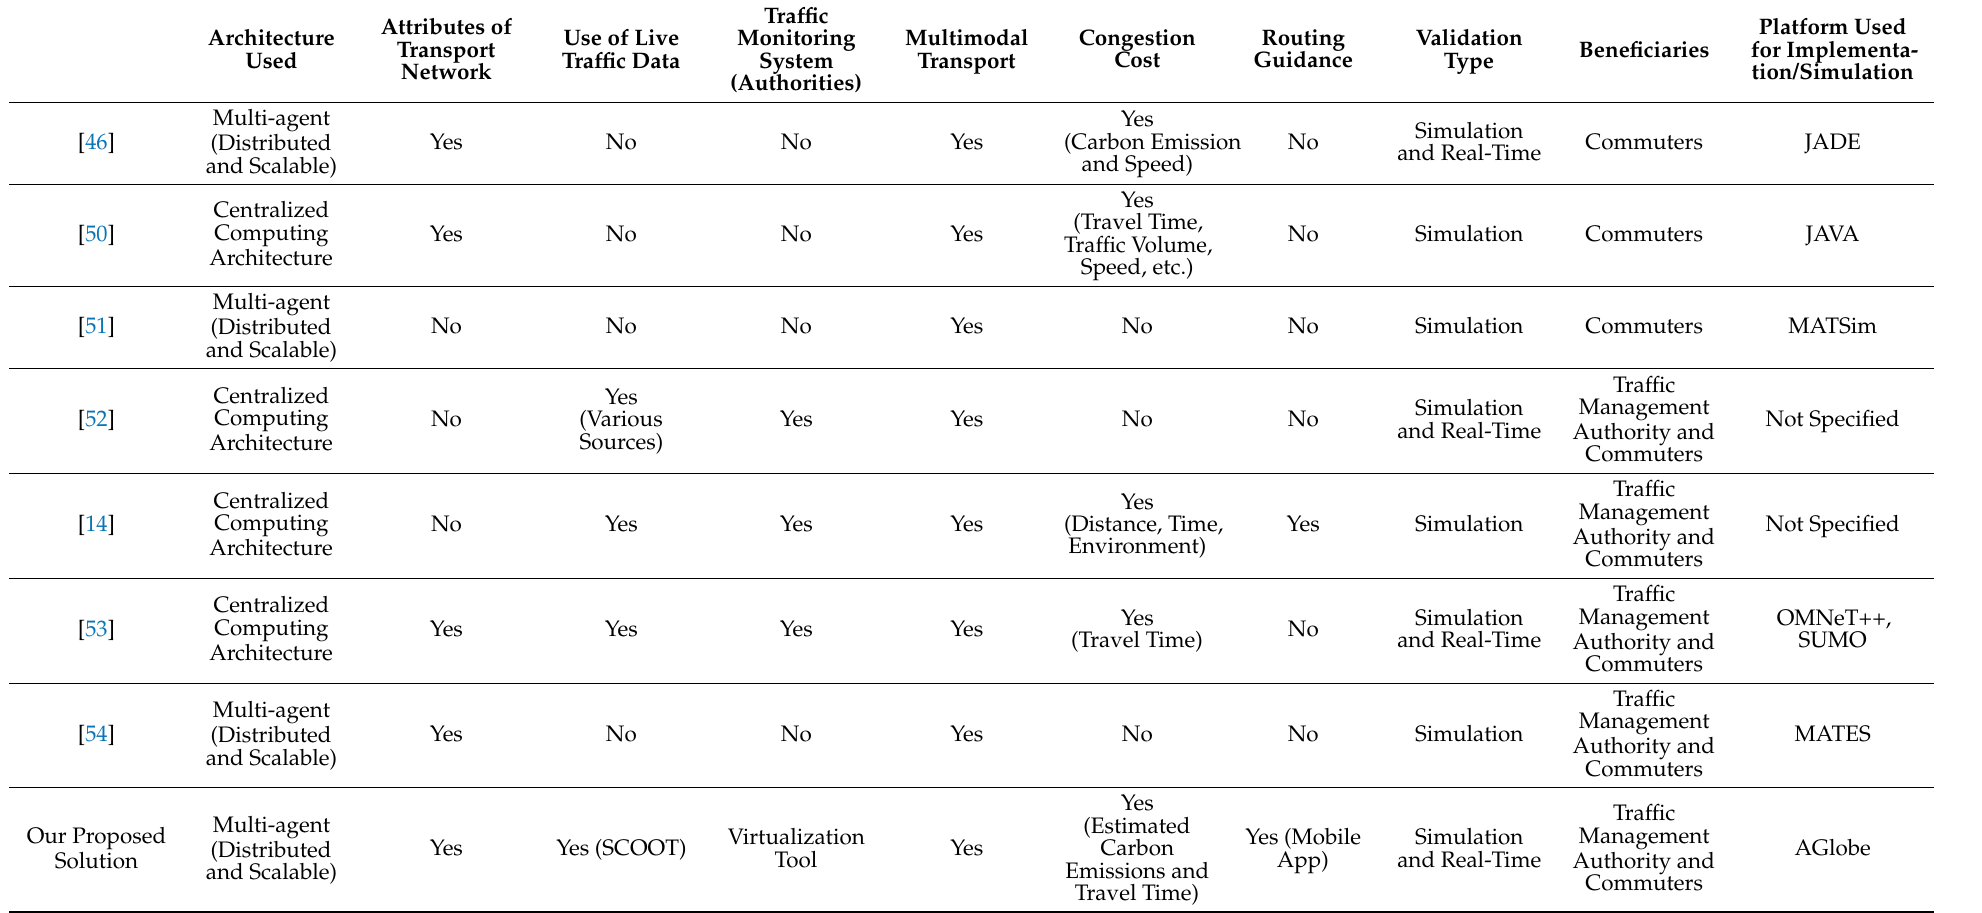
Table 1. Comparison of our multimodal route recommendation approach with existing